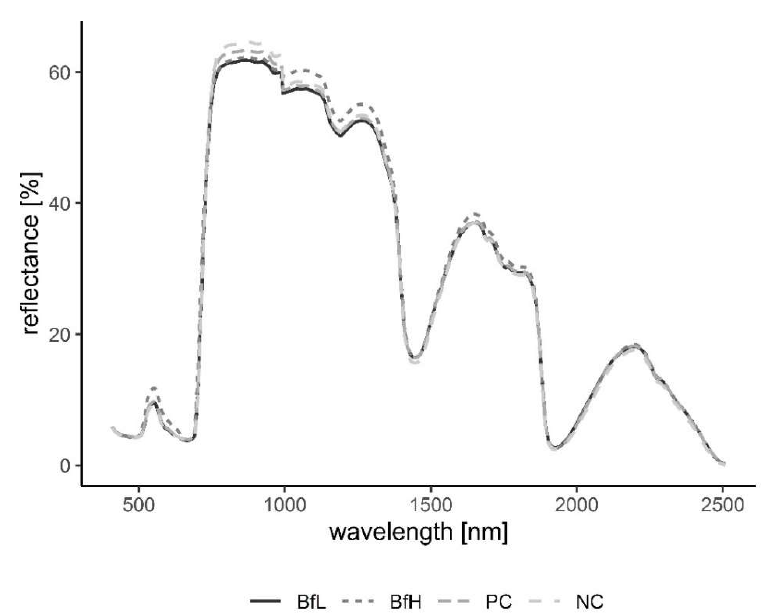
Figure 7. Averaged spectral signatures of the plants delineating the changes in reflectance at different wavelengths in the recorded spectrum. Signatures grouped according to treatments NC, PC, BfL and BfH in the pot experiment. Sample size per treatment, n = 4. NC—negative control; PC—positive control (nematicide); BfL—low B. firmus inoculum; BfH—high B. firmus inoculum.